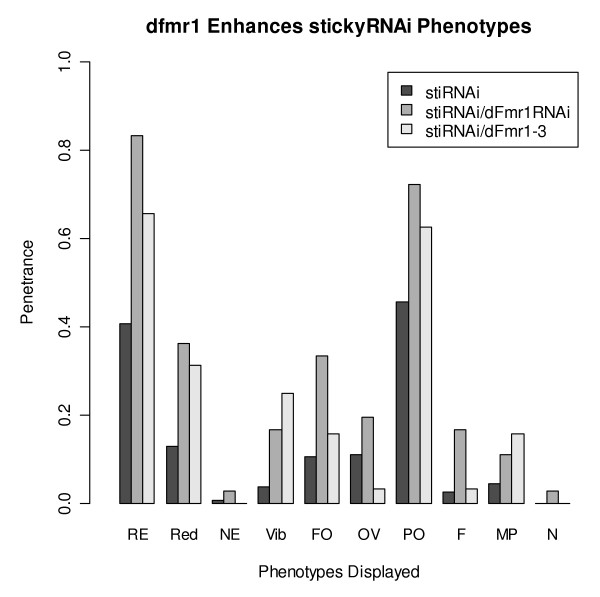
dFmr1 loss of function enhances sticky RNAi knockdown phenotypes. Plot of phenotype penetrance for the genotypes: ey-GAL4/+;UAS-sticky RNAi/+ (n = 162), ey-GAL4/UAS-dFmr1 RNAi; UAS-sticky RNAi/+ (n = 36), and ey-GAL4/+;UAS-sticky RNAi/dFmr13 (n = 32). No phenotypes were observed in flies of the genotype ey-GAL4/UAS-dFmr RNAi (data not shown). Phenotypes included are Rough Eye (RE), Reduced Eye (Red), No Eye (NE), Vibrissae (Vib), Frontorbital bristles (FO), Orbital and Vertical bristles (OV), Postorbital bristles (PO), Frontal bristles (F), Maxillary Palps (MP), and Necrosis (N). For RE, Red, Vib and PO we found statistically significant enhancement in the double RNAi lines when compared to the sticky-RNAi line alone, p < 0.05 in a Fisher's Exact test. This was also true for sticky-RNAi line in a dFmr13 heterozygous compared to the sticky-RNAi line alone.